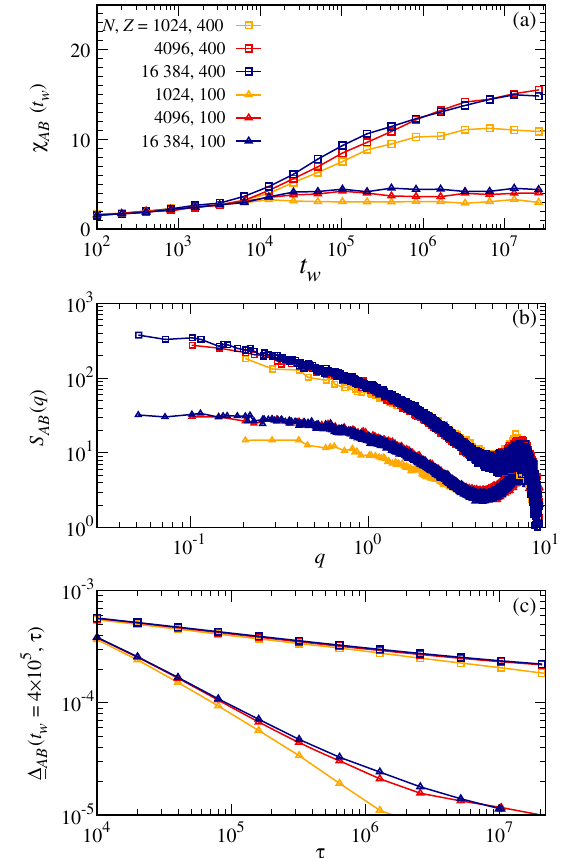
FIG. 14. Finite size effects via system sizes N ¼ 1024 , 4096, and 16384 for Z ¼ 100 and 400. (a) Time evolution of suscep- ð t Þ . (b) Structure factor of distance field, S ð q Þ at tibilities χ AB w AB ¼ 2 18 × 100 . (c) Time decay of Δ ð t ¼ 4 × 10 5 ; τ Þ . All data t w AB w converge rapidly with N , indicating a maximal correlation length of about L= 2 ≈ 30 , the linear system size for N ¼ 4096 .